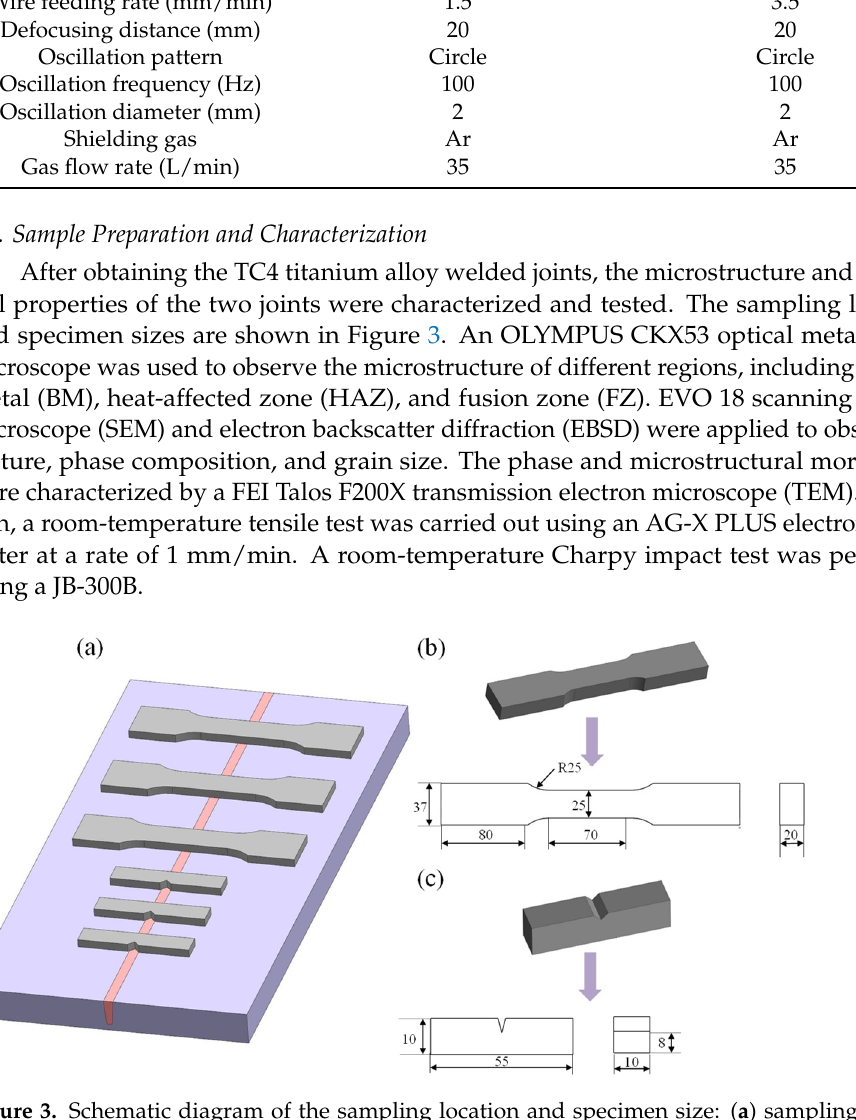
Figure 3. Schematic diagram of the sampling location and specimen size: ( a ) sampling location; ( b ) tensile specimen size; ( c ) impact specimen